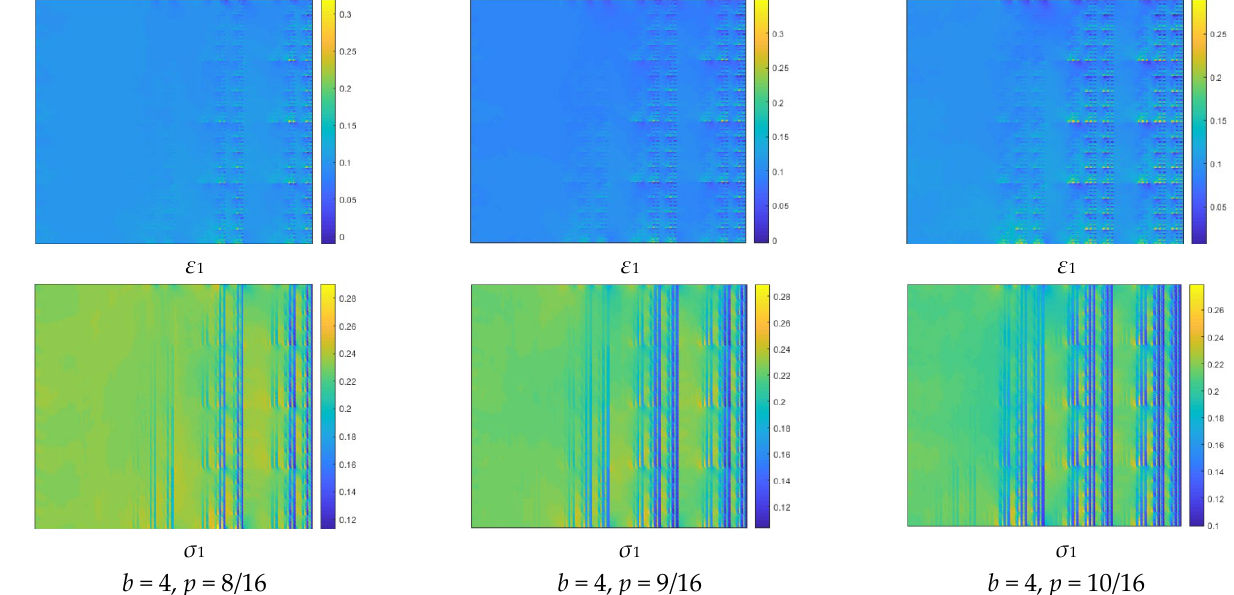
Figure 10. Dimensionless strain and stress (ε 1 , σ 1 ) within multifractal porous materials synthesized by the two-parameter binomial multiplicative cascades.